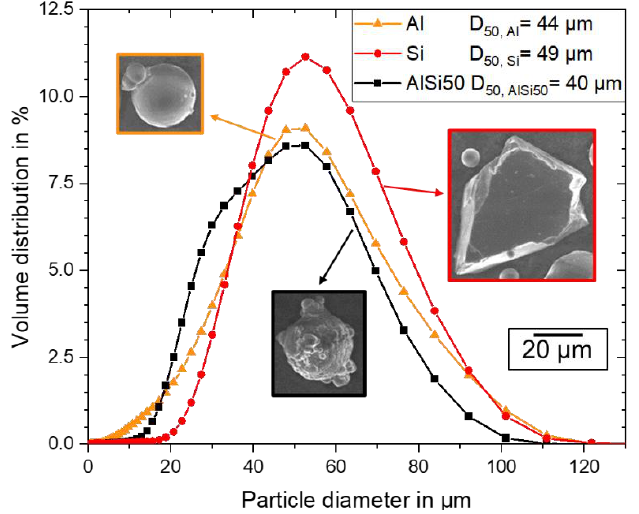
Figure 1. Particle size distribution and SEM images of the elemental Al and Si powders and the pre-alloyed AlSi50 powder measured via laser diffraction.